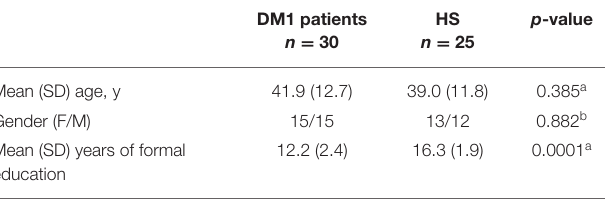
TABLE 1 | Demographic and clinical characteristics of participants.